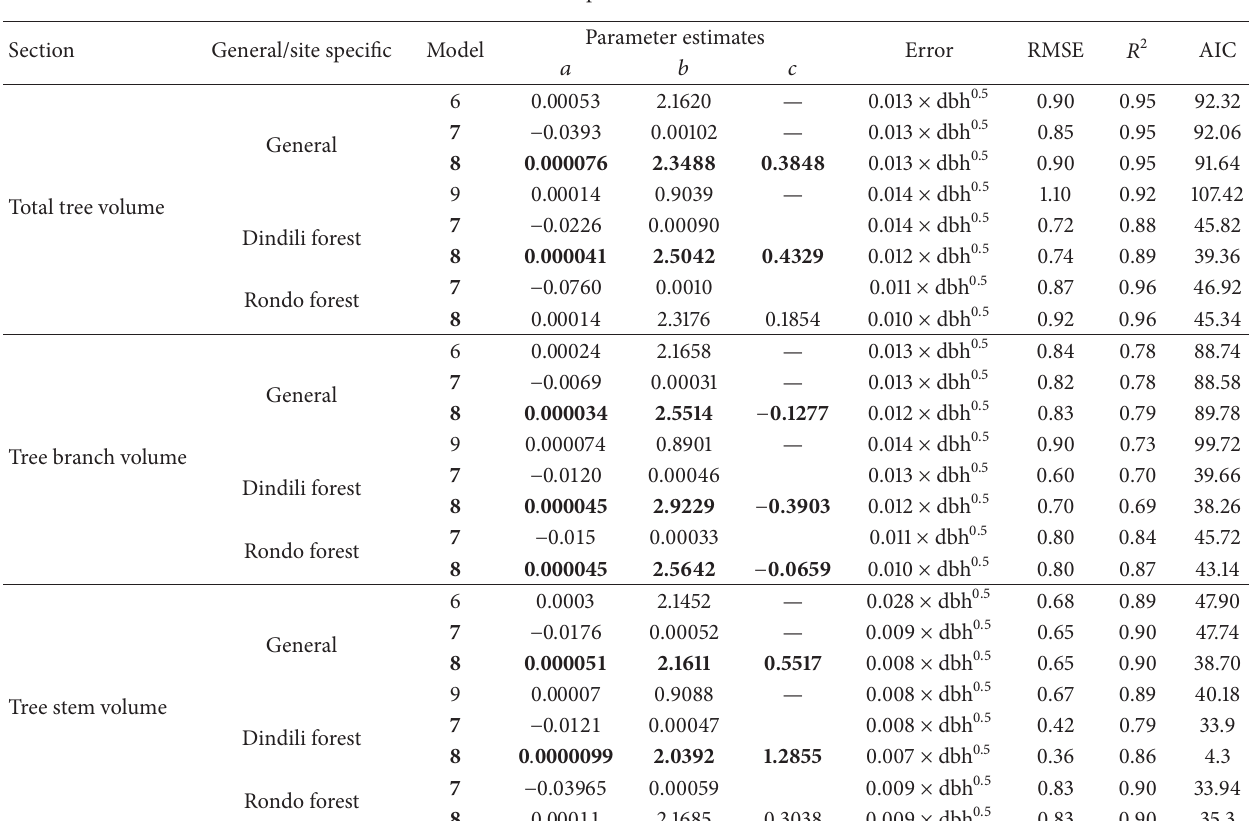
Table 3: Parameter estimates and volume models performance for individual total tree and sectional